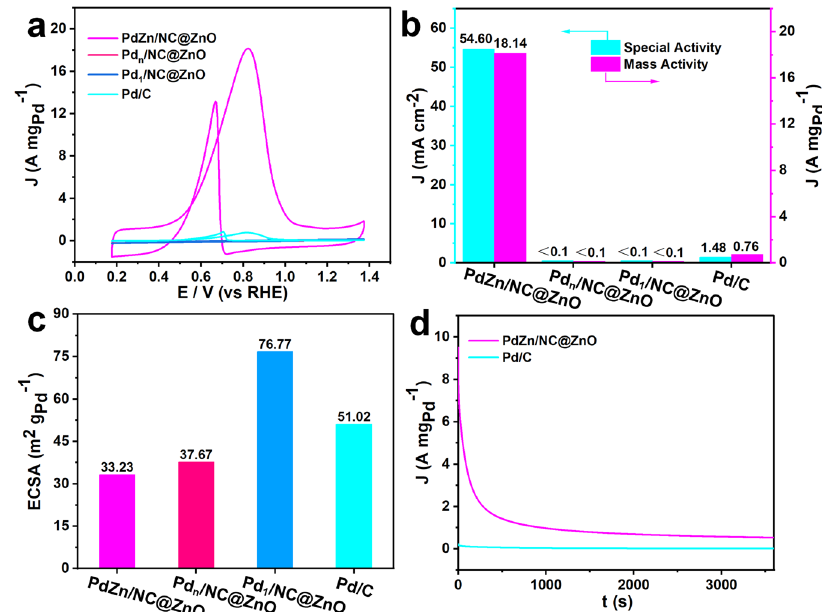
Fig. 3 Catalytic activity and durability evaluation. a CV curves of PdZn/NC@ZnO, Pd n /NC@ZnO, Pd 1 /NC@ZnO, and commercial Pd/C, recorded in N 2 - saturated 1.0 M KOH and 1.0 M C 2 H 5 OH at room temperature at scan rate of 50 mV s − 1 . b Mass and speci fi c activities of PdZn/NC@ZnO and commercial Pd/C. c ECSA values of PdZn/NC@ZnO, Pd n /NC@ZnO, Pd 1 /NC@ZnO, and commercial Pd/C. d Chronoamperometry curves of PdZn/NC@ZnO and commercial Pd/C, recorded at their corresponding peak potentials at − 0.30 V vs Ag/AgCl in aqueous solution containing 1.0 M KOH and 1.0 M C 2 H 5